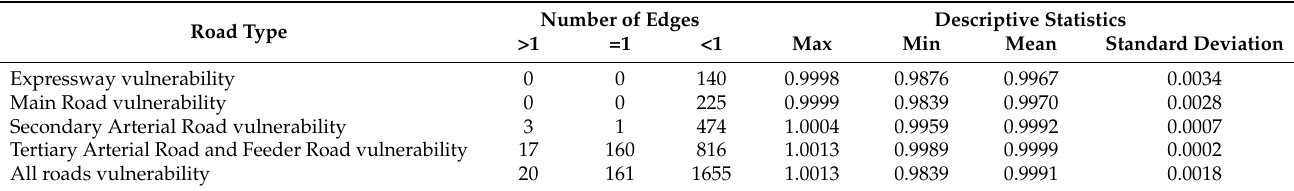
Table 4. Descriptive statistics of the road vulnerability.